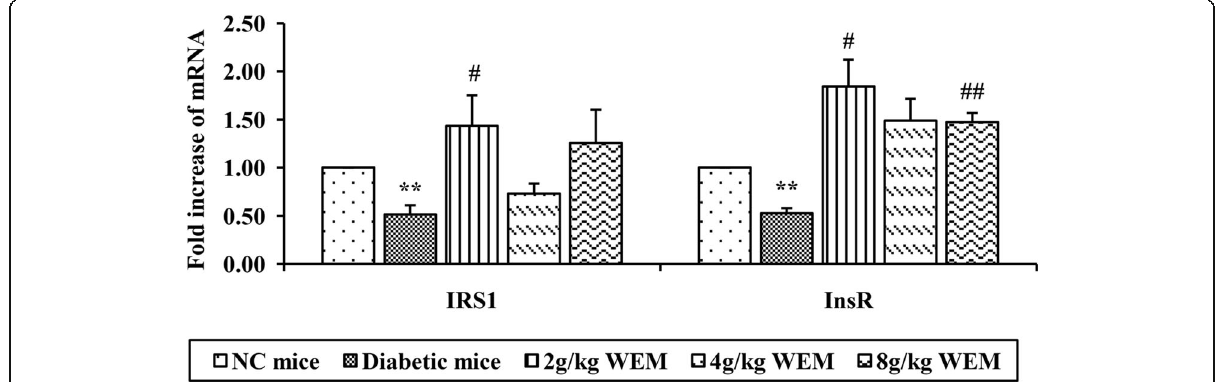
Fig. 9 The gene expression of IRS1 and InsR affected by WEM in adipose tissue. WEM could increase the relative expression of IRS1 and InsR compared with diabetes. Data are shown as intensity ± SEM ( n = 6to5). * P < 0.05, **P < 0.01, NC mice vs. Diabetic mice; # P < 0.05, ## P < 0.01, WEM vs. Diabetic mice